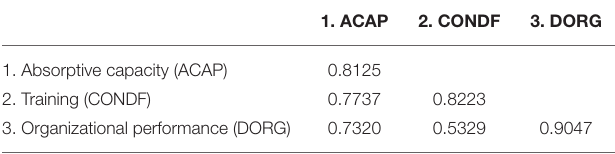
TABLE 4 | Inter-construct correlations matrix: discriminant validity (Model B).